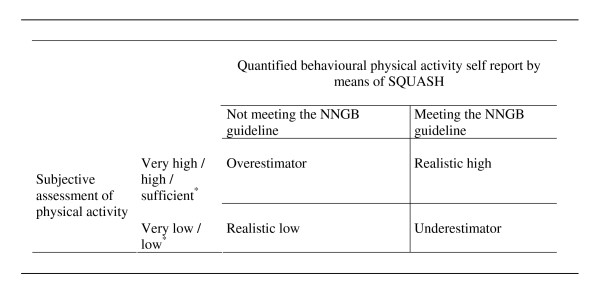
Classification of respondents in categories of misperception6. * answering categories in subjective assessment.